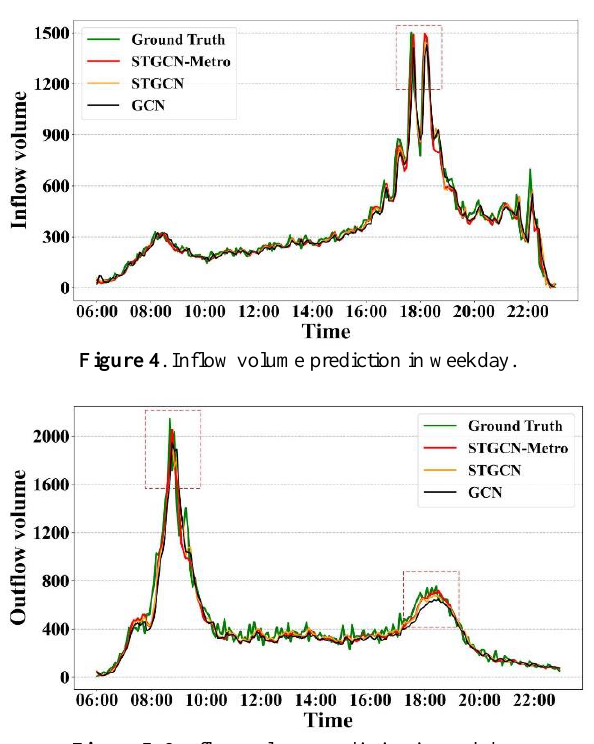
Figure 5 . Outflow volume prediction in